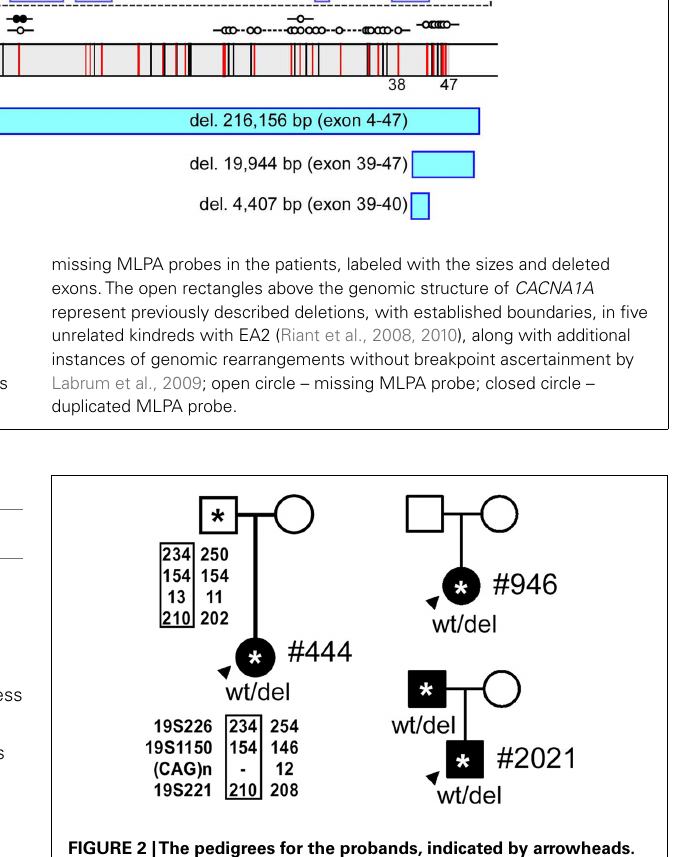
FIGURE 2 |The pedigrees for the probands, indicated by arrowheads. (*, DNA sample obtained; closed symbol, affected; circle – female; square – male). Genotyping of Patient #444 and her father with 19p markers (from 5 (cid:2) to 3 (cid:2) , 19S226, 19S1150, polymorphic CAG repeats, and 19S221) are shown with the pedigree. Haplotypes shared between the patient and the father are highlighted by rectangles.